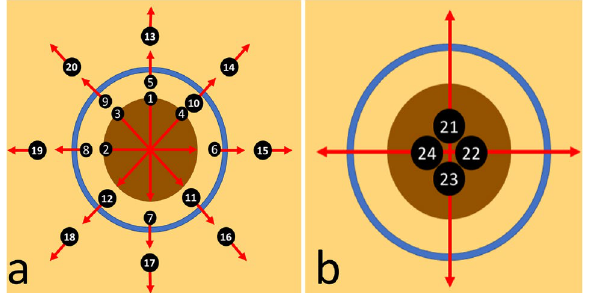
Figure 2. Radial scans performed using the sfOCT along ( a ) clinically apparent tumor (1–4), marked surgical margin (5–12), adjacent normal skin (13–20), and ( b ) a combination of the three